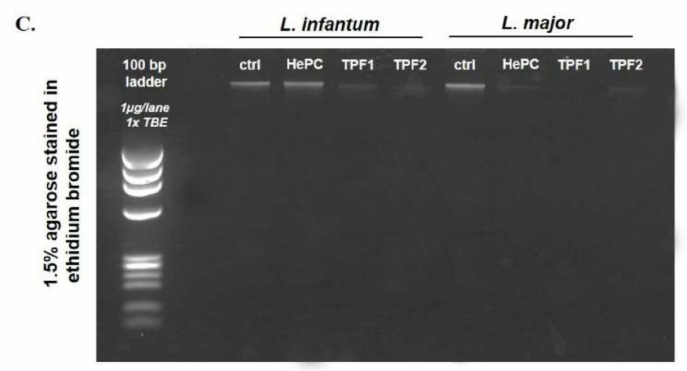
Figure 7. TPF1 and TPF2 induced DNA fragmentation in L. infantum and L. major promastigotes. Log-phase L. infantum and L. major promastigotes were either left untreated (negative control) or were treated with IC 50 and 2 × IC 50 doses of TPF1, TPF2 and HePC (positive control) for 72 h. ( A ) Flow cytometric single parameter histograms (FL1-H) representative of one experiment. ( B ) Bar diagrams illustrating the mean TUNEL+ L. infantum and L. major parasites ( ± SD) and are representative of three independent experiments. The symbols of * and # indicate significant differences compared to the negative and positive control groups, respectively. Significant differences between TPF1- and TPF2-treated parasites are indicated with (cid:54) = . ( C ) Genomic DNA fragmentation assay on a 1.5% agarose gel.